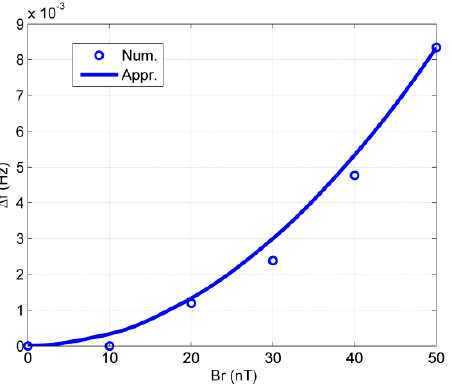
Figure 3. The frequency shift vs. DC magnetic field in the y -axis. “Num.” and “Appr.” in the figure denote numerical and approximate analytical results, respectively.